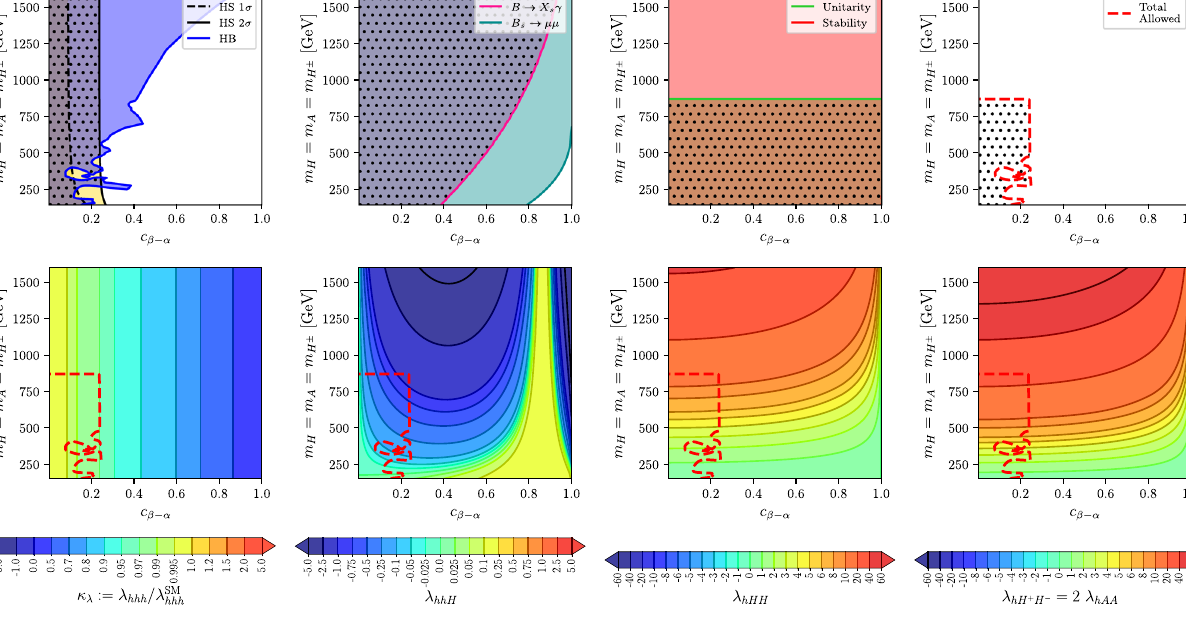
Fig. 15 Allowed areas (dotted regions) from the various constraints (upper row) and triple Higgs couplings (lower row) for the benchmark scenario IV-4 in the c β − α – m plane with m 2 fixed by Eq. (6) and tan β fixed via Eq. (9) (wrong sign Yukawa 12